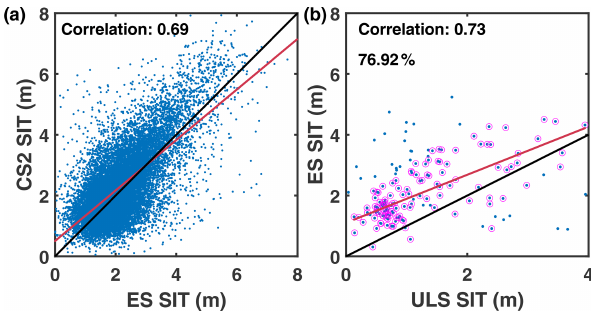
Figure 2. (a) The monthly ES- and CS2-derived SIT in the Weddell Sea during the coincident segment from November 2010 to Novem- ber 2011 and (b) the monthly ES-derived SIT and ULS observations during the coincident segments at sites 206, 207, 208, 229, 231 and 233. The red lines are linear regression lines, and the black lines are one-to-one lines. The dots surrounded by red circles indicate the ULS SIT is within the uncertainty of ES, and the percentage in (b) denotes the proportion of such dots. The correlation and regression lines in (b) are only for dots surrounded by red